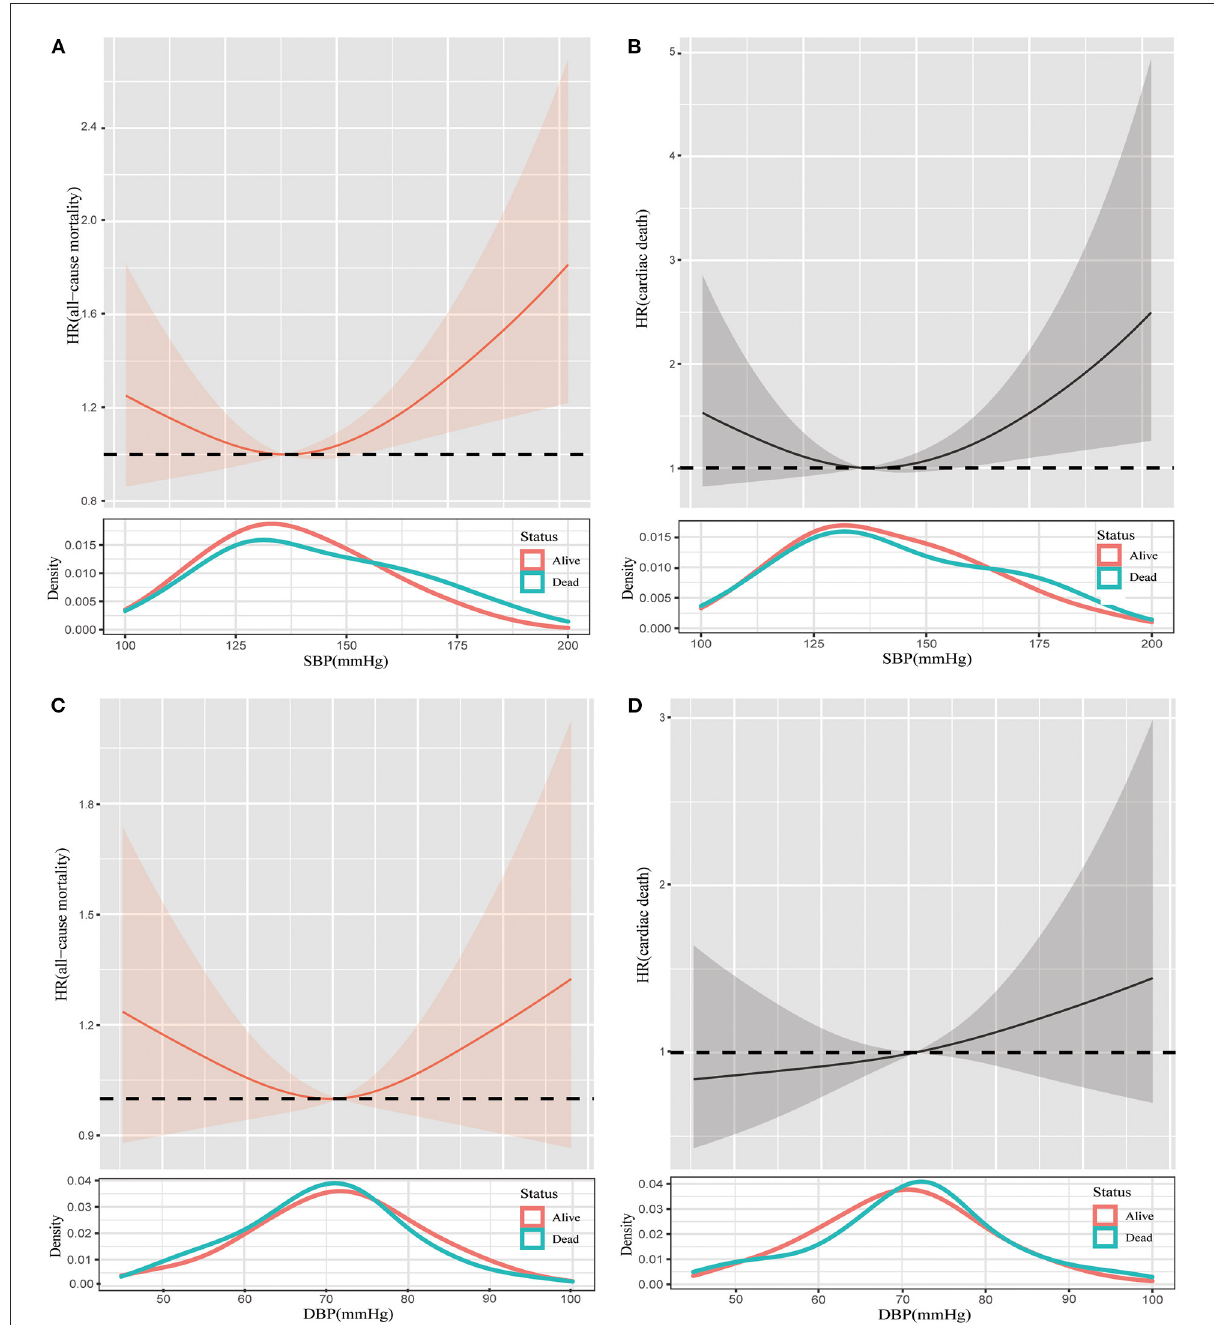
FIGURE2 Restricted cubic spline plots of the association between SBP and all-cause mortality (A) , SBP and cardiac death (B) , DBP and all-cause mortality (C) , and DBP and cardiac death (D) in (pre)frail participants. Analysis was adjusted for age, gender, race, diabetes, stroke, coronary artery disease, smoker, antihypertensive medication, and frailty. SBP, systolic blood pressure; DBP, diastolic blood pressure; HR, hazard